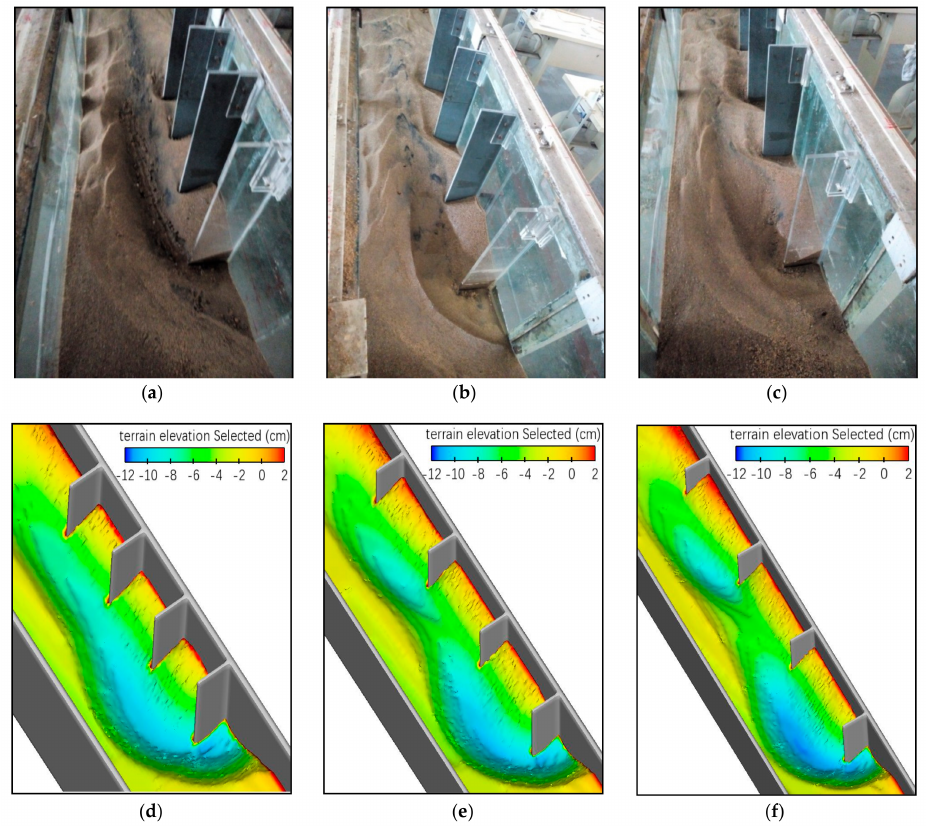
Figure 5. Final bed configuration with spur dikes spacing 2 l , 3 l , 4 l . ( a ) experiment for 2 l spacing; ( b ) experiment for 3 l spacing; ( c ) experiment for 4 l spacing; ( d ) simulation for 2 l spacing; ( e ) simulation for 3 l spacing; ( f ) simulation for 4 l